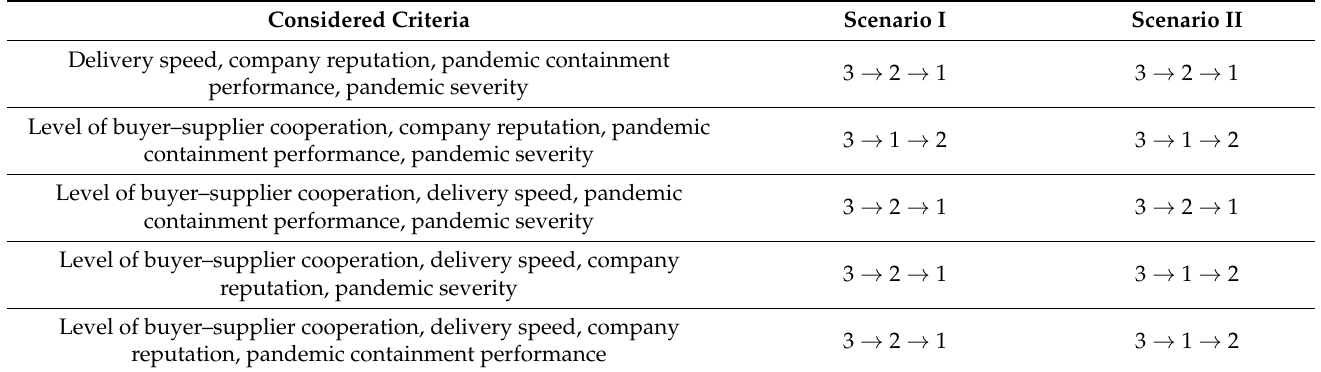
Table 10. The ranking result after dropping a criterion at a